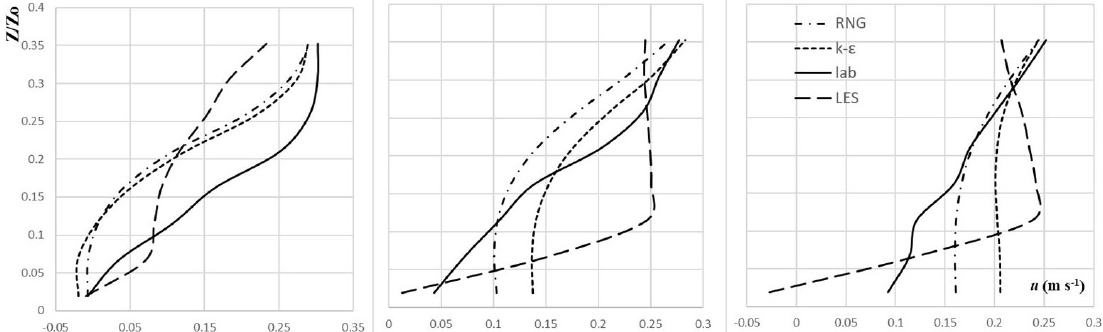
Figure 14. Comparison of measured and computed streamwise velocity profiles (m s − 1 ) in the experimental zone for ( A ) 2.45 m; ( B ) 2.50 m and ( C ) 2.55 m from origin.